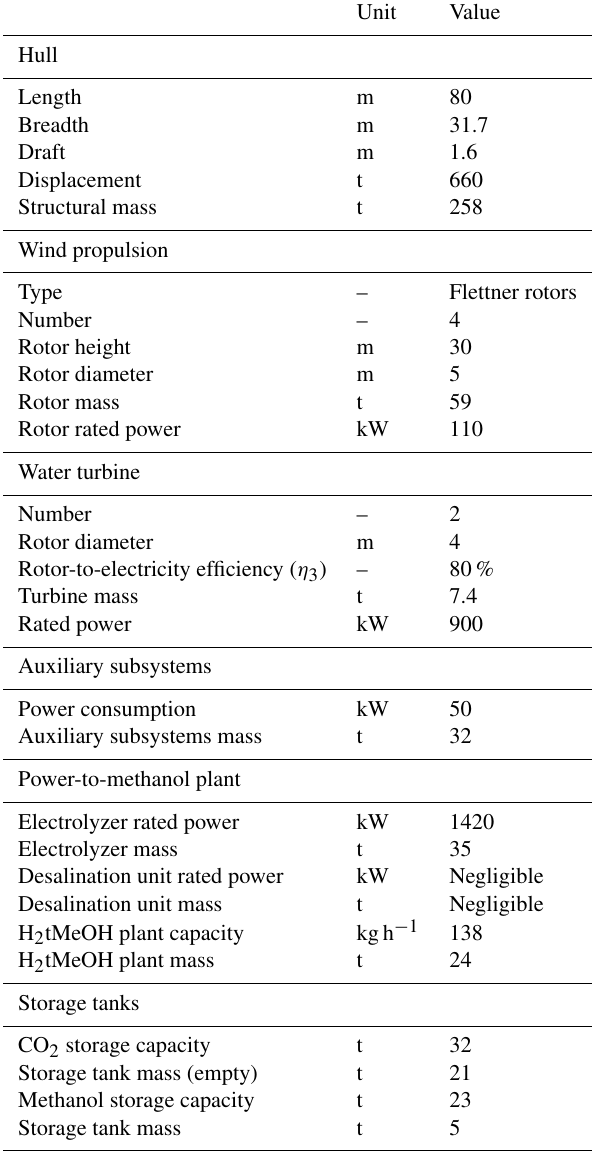
Table 1. Specifications of the proposed energy ship design.